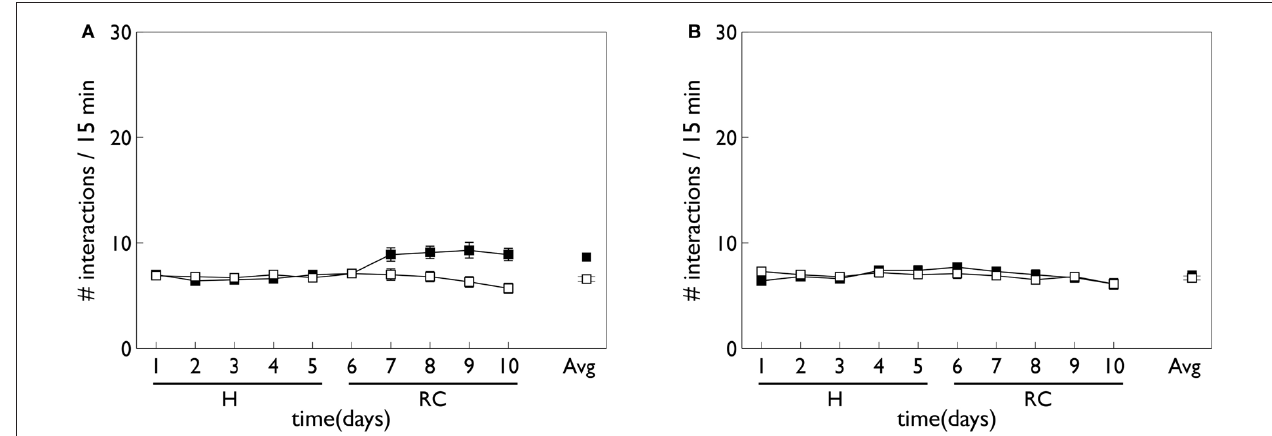
days. Error bars are 1 standard error of the mean. Open symbols are for the white (control) block while solid symbols are for the red block, which elicits a phasic outcome in the response contingent phase (labeled “RC”). The habituation phase (when there is no environmental phasic outcome) is designated “H.” The average of the interactions for each block over the entire response contingent phase is shown in the pair of data points on the extreme right of each